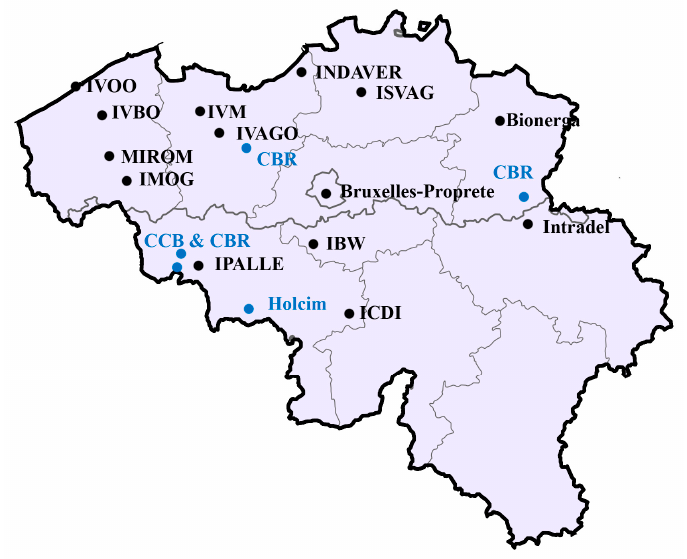
Figure 7. Areal distribution of major incineration plants and cement plants in Belgium (black, incineration plants; blue, cement plants) cf. [22,134].